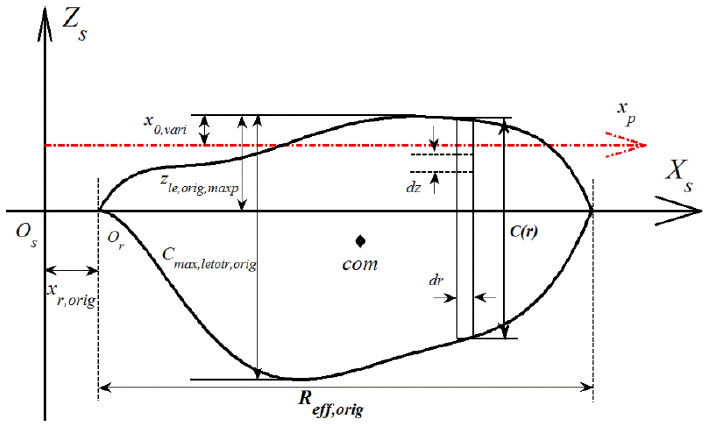
Figure 1. Definition of wing shoulder frame ( X s O s Z s ) and basic size for fruit fly wing planform.